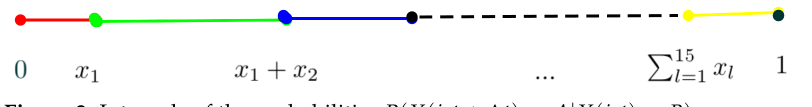
Figure 3. Intervals of the probabilities P ( X ( i , t + ∆ t ) = A | X ( i , t ) = B ) .